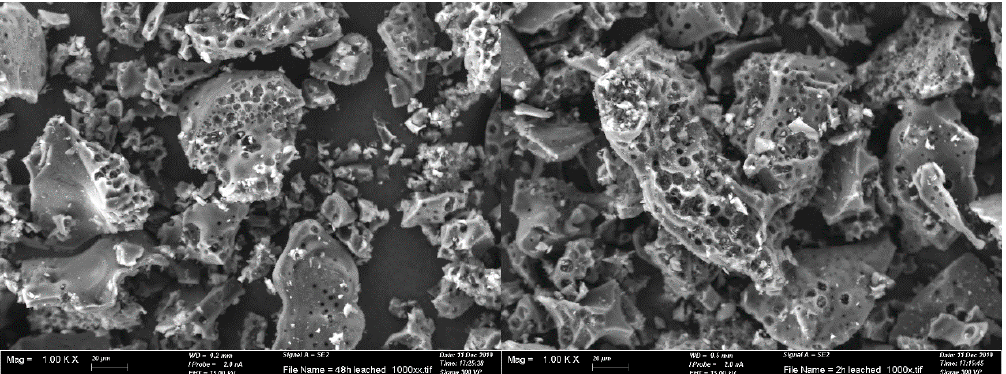
Figure 12. Pore size distribution (BJH) of original and the leached char samples. Energies 2020 , 13 , x FOR PEER REVIEW